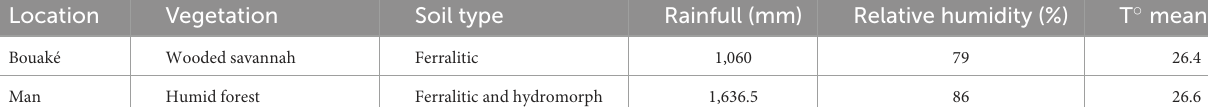
TABLE 1 Agro-ecological characteristics of cassava field assessment sites in Bouaké and Man, Côte d’Ivoire.